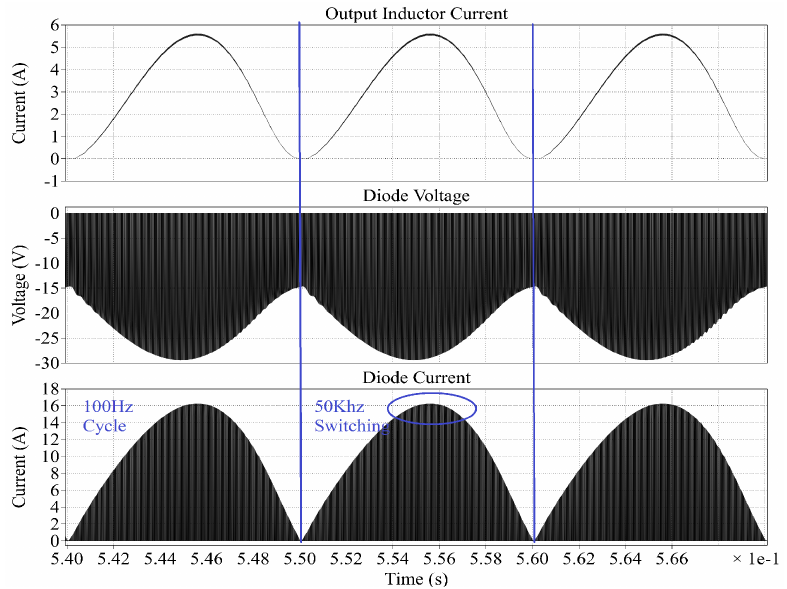
Figure 10. Waveforms in the output side of the DC-DC converter: output inductor current i o , diode voltage V diode , and diode current i diode .